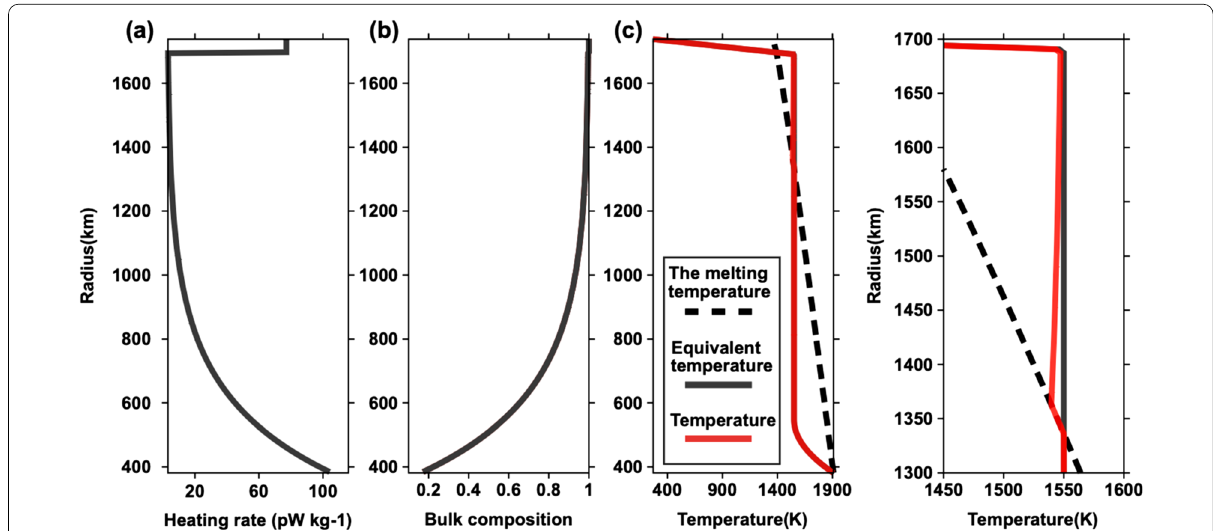
Fig. 1 The initial condition. Illustration of the initial distribution of a internal heating rate, b bulk composition, and c temperature. The assumed parameter values in the figure are: the temperature of the mid-mantle T M = 1550K ; the ratio of the concentration of HPEs in the crust to the mantle F ∗ 8 ; the thickness of the high-density layer after mantle overturn L ∗ = 1 / crst =